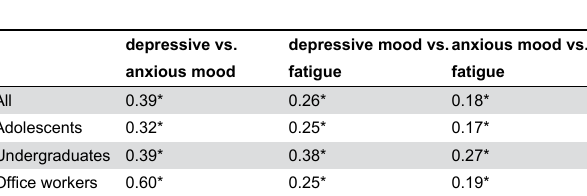
Table 2. Convergent associations (correlations) among self-reported mood and fatigue